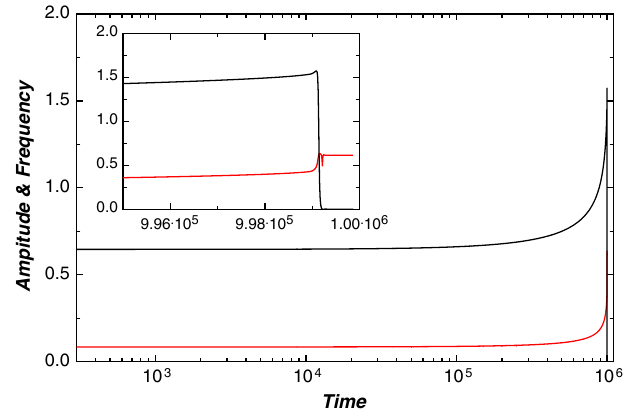
FIG. 7. An evolution that runs a million M. The frequency is depicted in red. The top black line representing the amplitude has been rescaled by 1 =(cid:8) . The inset shows the final